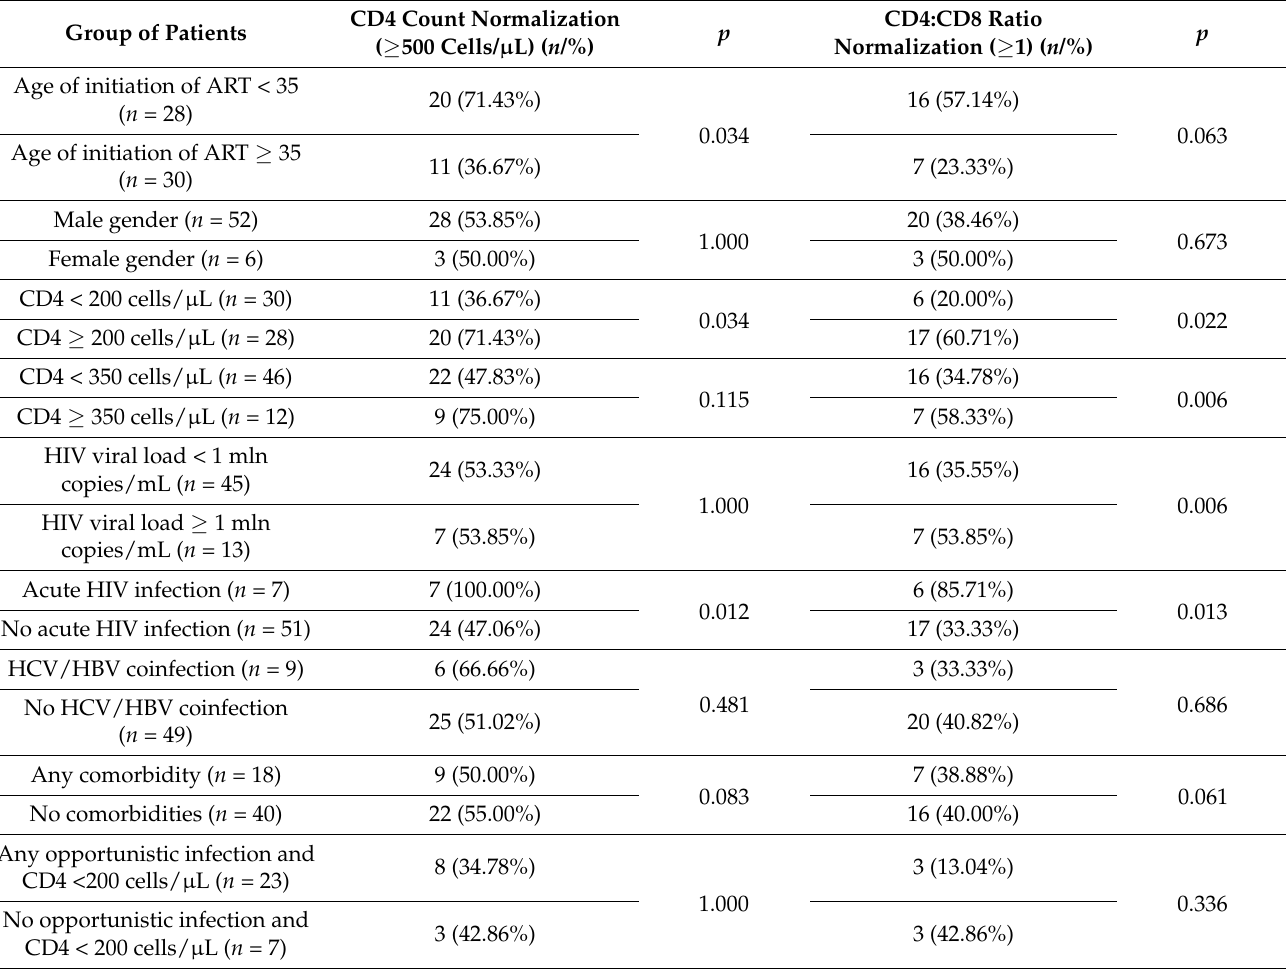
Table 4. CD4 cell count and CD4:CD8 normalization depending on clinical